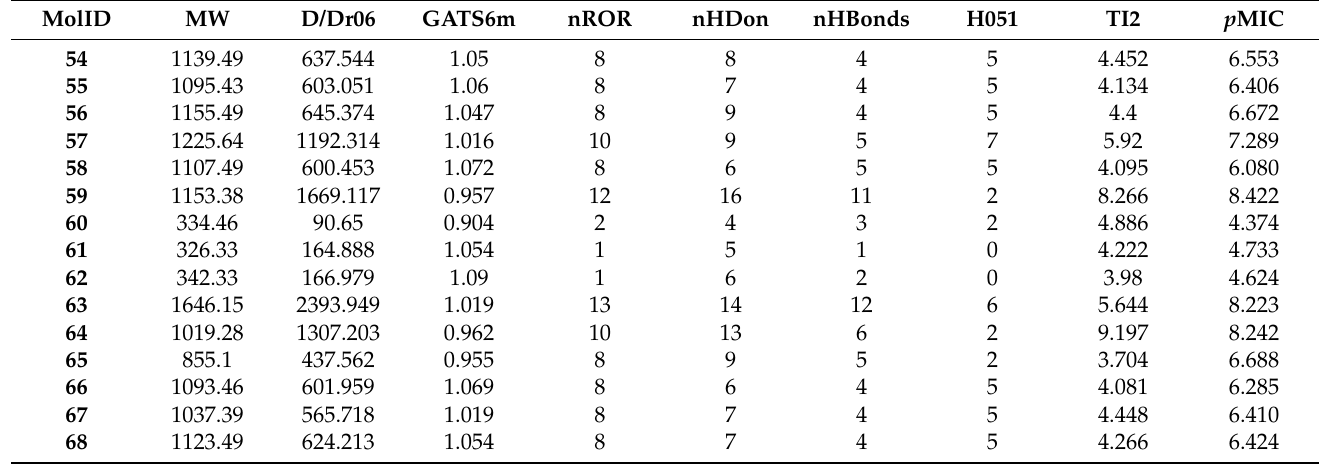
Table 2. Molecular descriptors for natural products 54 to 68 with their predicted pMIC